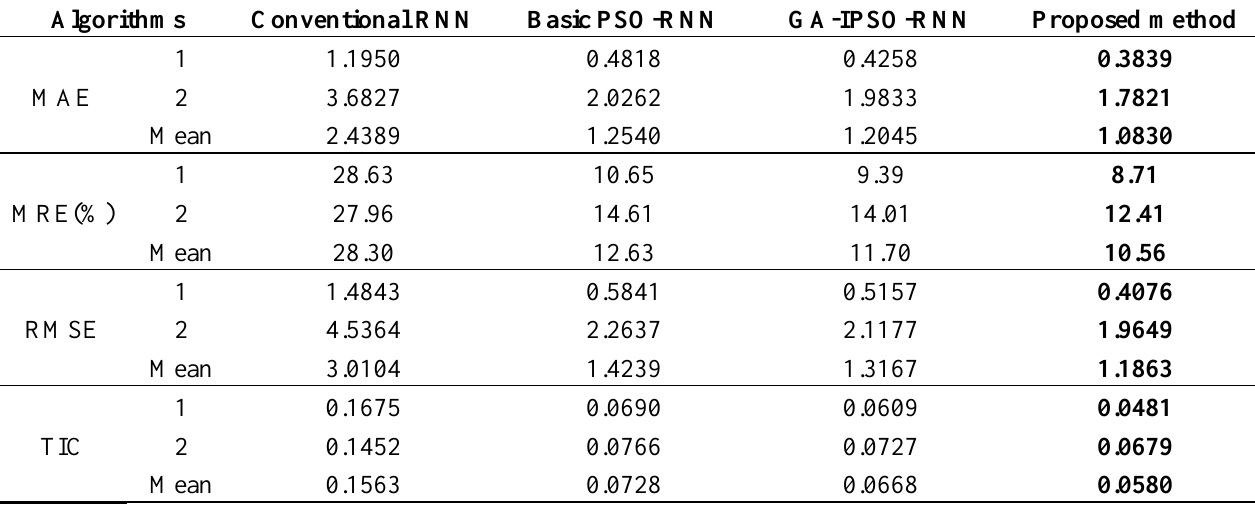
Table 2. Comparison of errors among the proposed method, the GA-IPSO-RNN [9], the basic PSO-RNN [9], and the conventional RNN